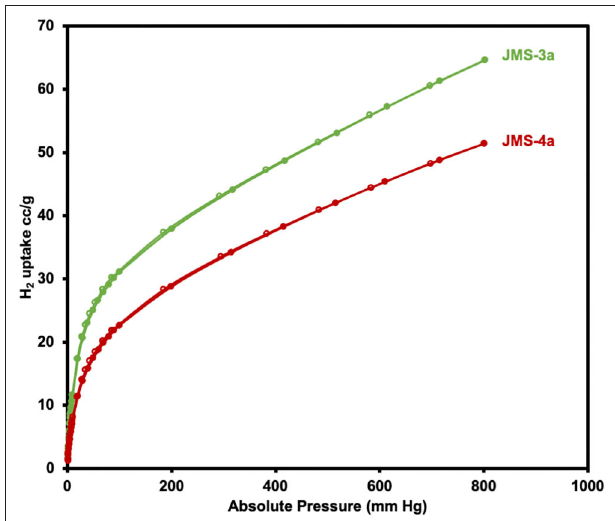
FIGURE 11 | Adsorption and desorption isotherms of JMS-3a and JMS-4a at 77K for H 2